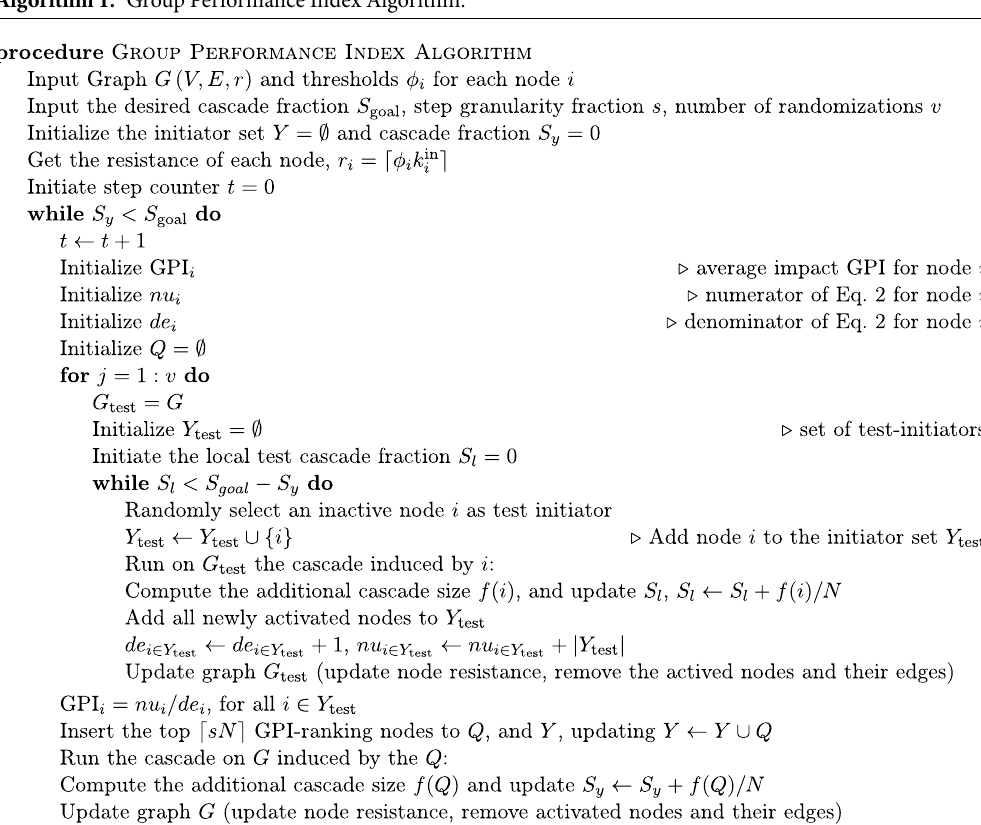
Algorithm 1. Group Performance Index